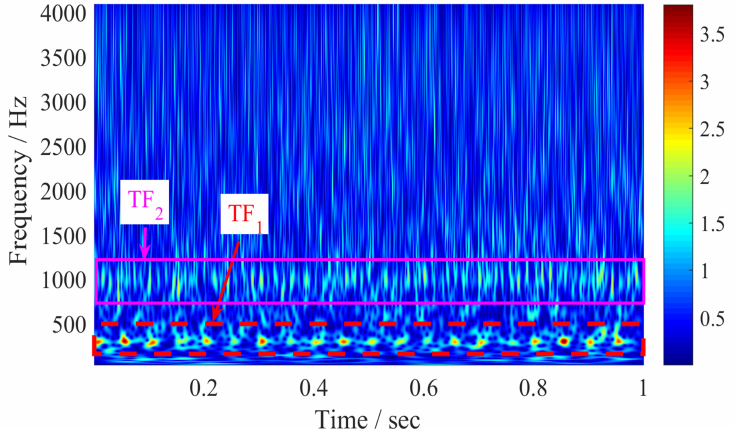
Figure 6. Time-frequency representation of simulated